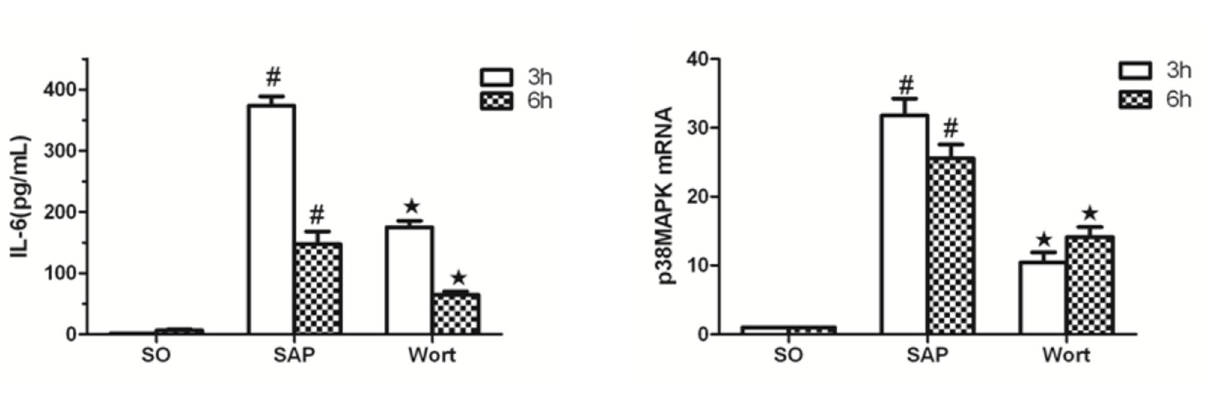
Figure 6. IL-6 level in each group at the 3 h and 6 h time point. # P <0.05 vs. SO group; ★ P <0.05 vs. SAP group.